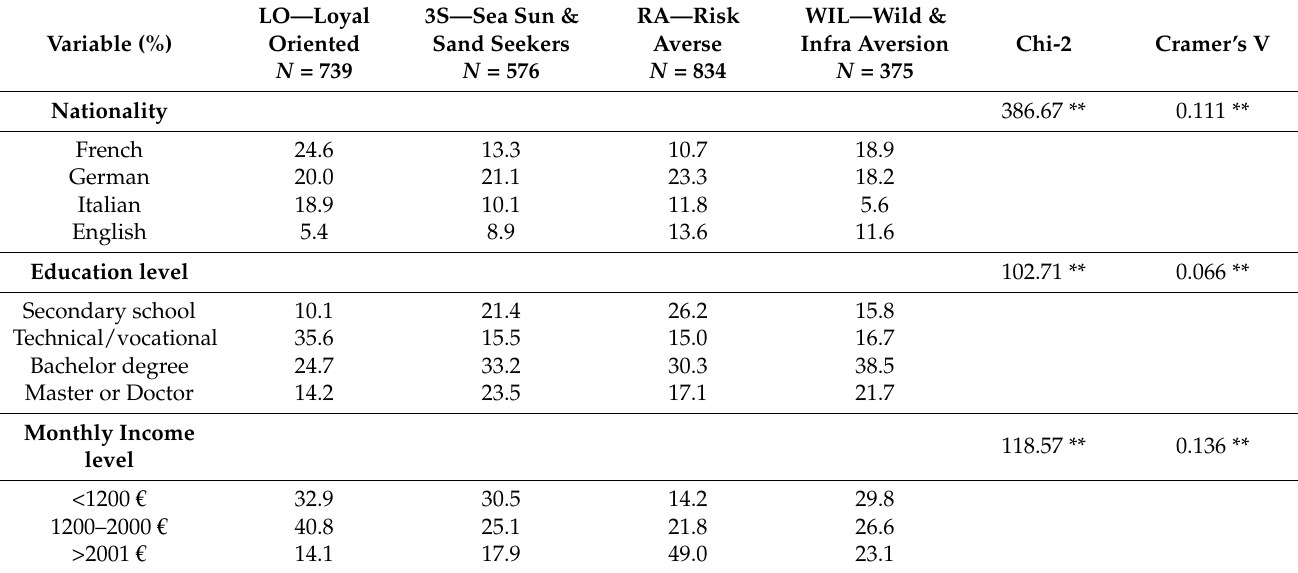
Table 4. Socio-demographics of tourists by segment (** p < 0.01).